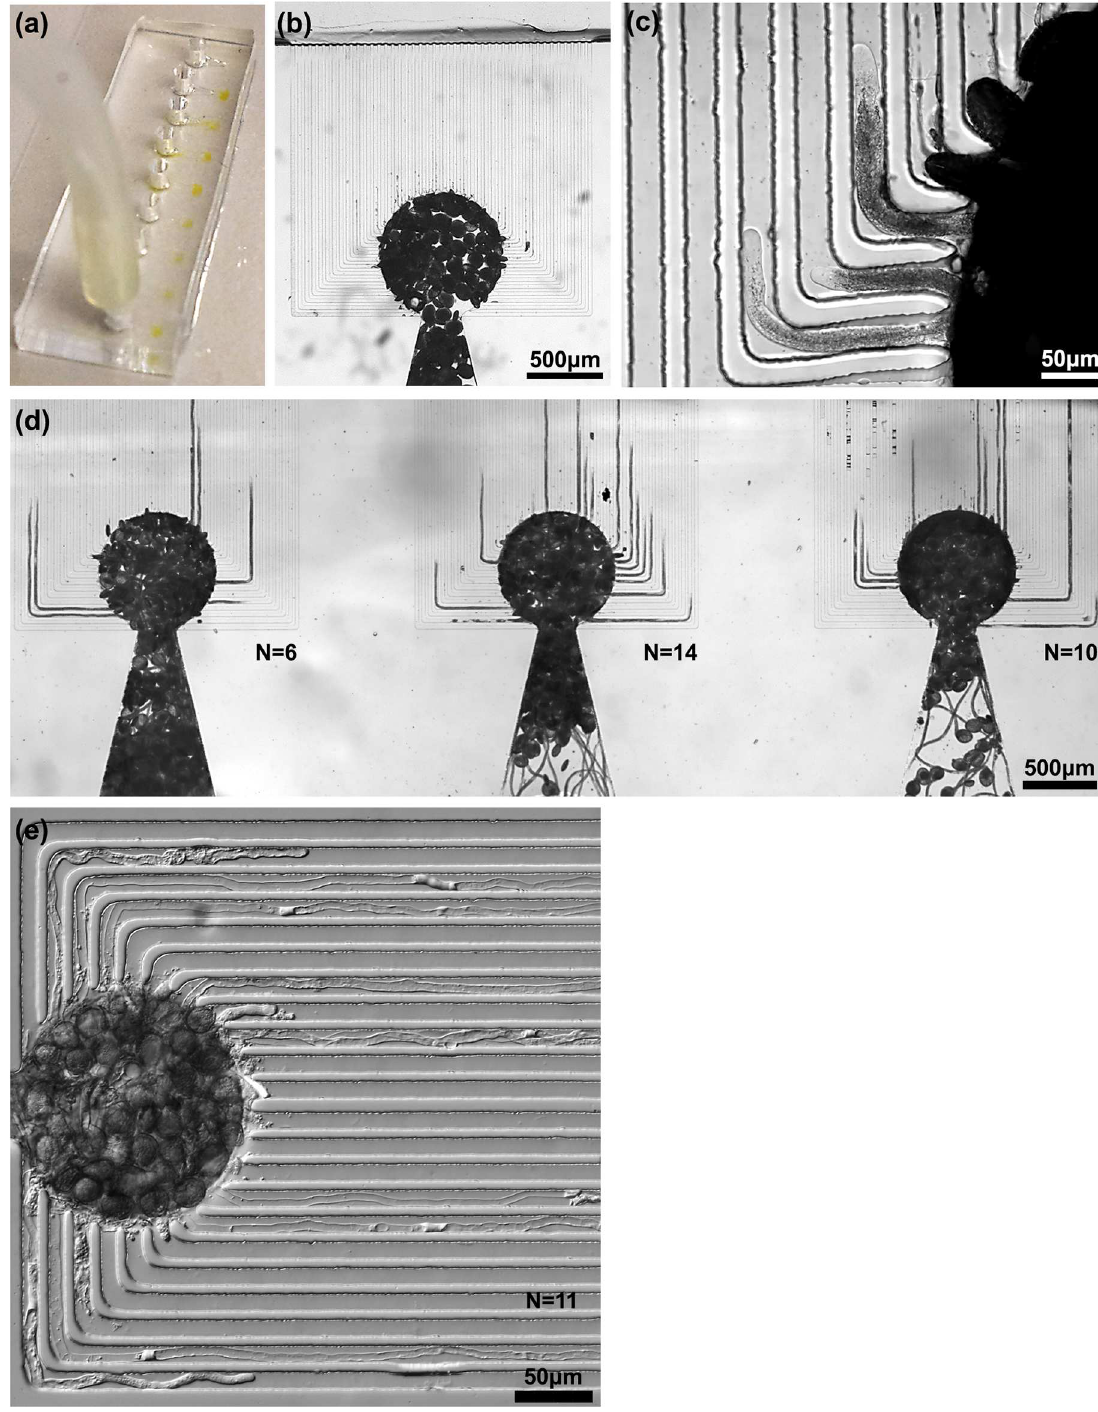
Fig 2. Germination, growth, and parallel guidance of pollen tubes in the LoC device. (a) The LoC is injected with nutrient medium containinglily pollengrains that become concentrated and appearas yellowishcircles. (b) A view of a lily unit cell immediately after injectionof grains. (c) Three lily pollentubes are guidedinto neighboring channels and can be simultaneously imaged at highmagnification. (d) A stitch of the three unit cells shows the equifocalunidirectional guidanceof a large number of lily pollentubes. (e) This stitch shows the guidance of eleven A . thaliana pollentubes in a singleunit cell. N = numberof tubes guidedin a unit